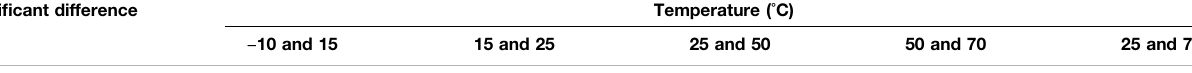
TABLE 6 | Differential analysis of the slope of fi tted equation. Signi fi cant